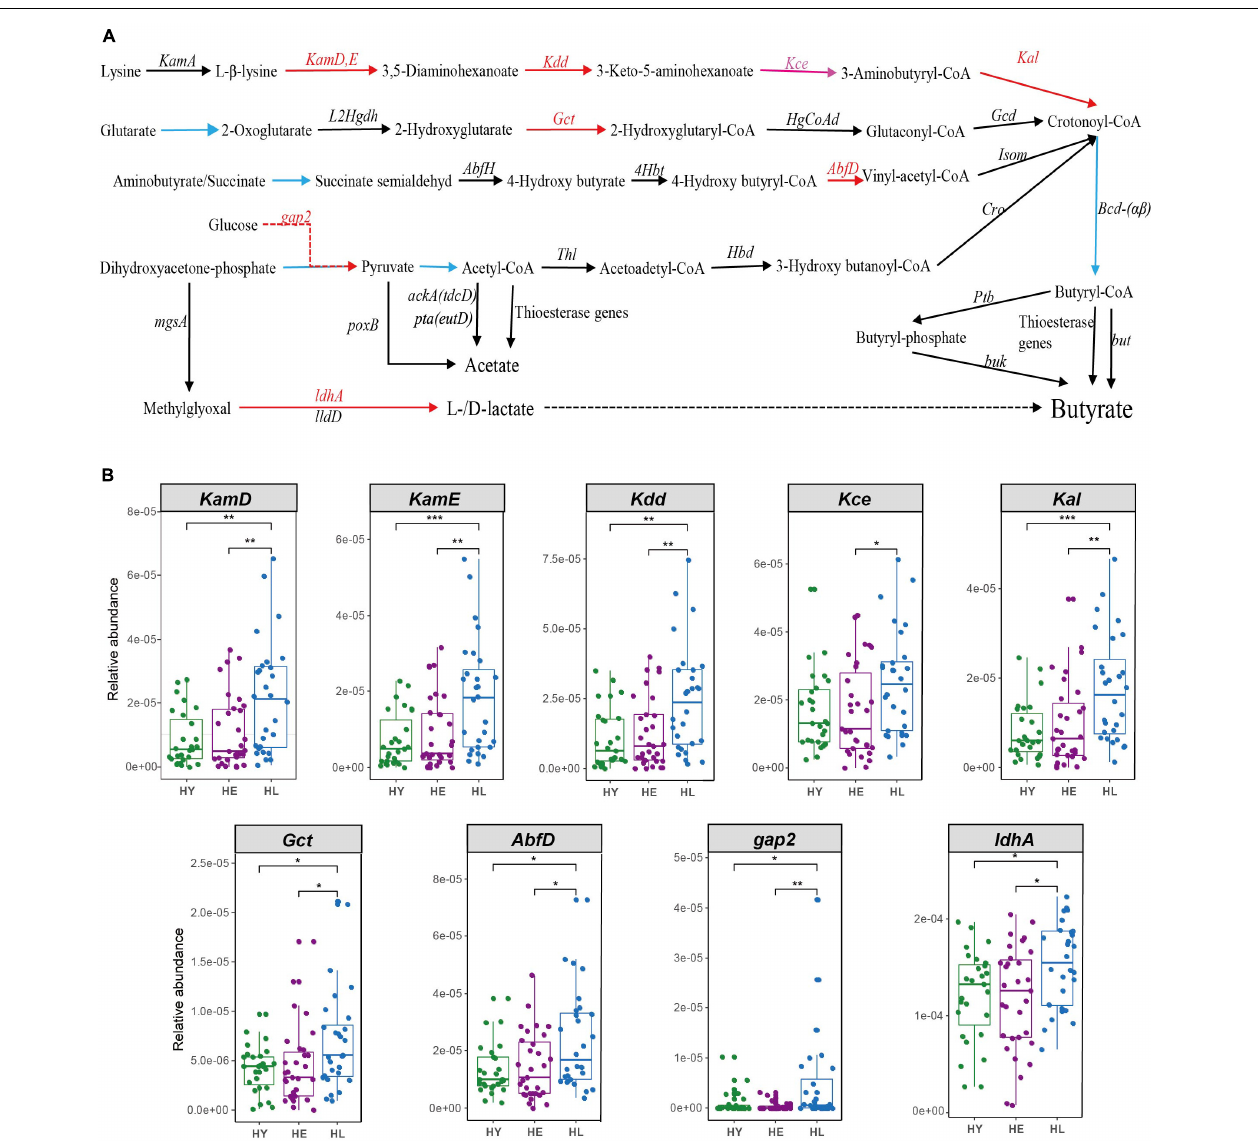
FIGURE 4 | Acetate, butyrate, and lactate biosynthesis pathways (A) and the relative abundance of the different genes between the three age groups (B) . Pathways for butyrate biosynthesis were drawn according to Vital et al. (2014) and Zhao et al. (2019); Pathways for acetate biosynthesis were drawn according to Zhao et al., 2019); Pathways for lactate biosynthesis were drawn according to Bourriaud et al. (2005). Red arrows, HL > HE HY, P < 0.05; pink arrows, HL > HE, P < 0.05; black arrows, no significant between the three age groups. The blue line from crotonoyl-CoA to butyryl-CoA was not analyzed, because it was shared by all four pathways leading to Butyryl-CoA. HL, long-living people; HE, elderly people; HY, young people. Statistical significance symbols: * P < 0.05; ** P < 0.01; *** P <